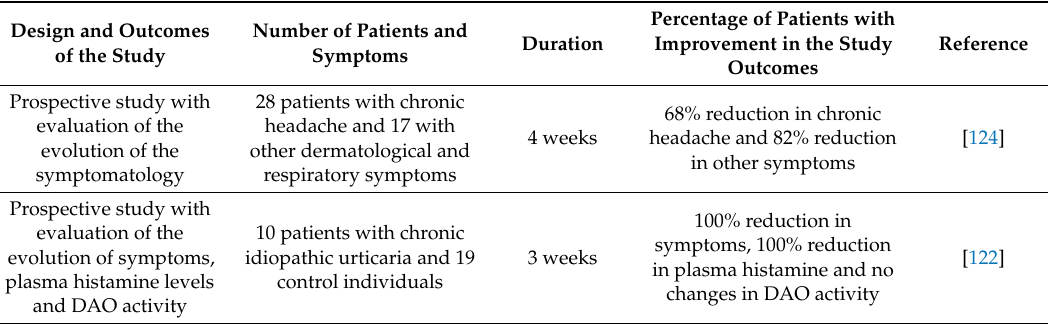
Table 4. Clinical studies on the e ffi cacy of a low-histamine diet for the treatment of symptoms of histamine